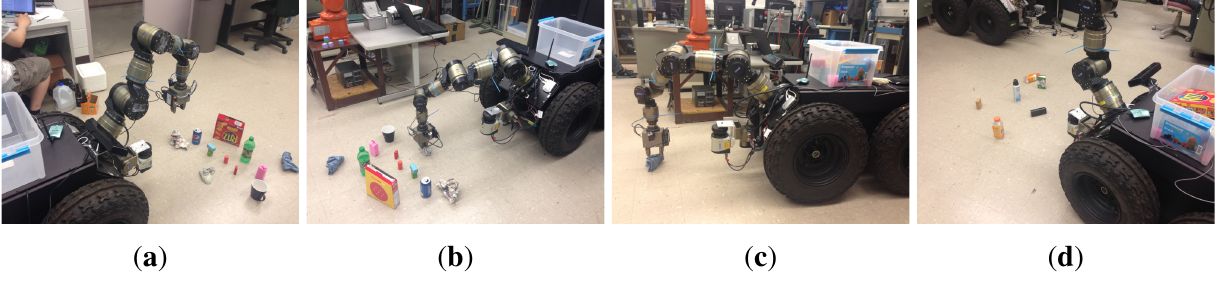
Figure 12. Snapshots of scenes when our robot is performing the task of cleaning up the ground. After detecting the unknown objects, the robot moves its gripper to the nearest object ( a ), grasps the object ( b ) and then puts it into the box. When the objects are out reach of the manipulator, the robot moves its base to facilitate grasping ( c ). After recycling all objects in the current spot, the robot continues to find objects and moves to the next spot ( d